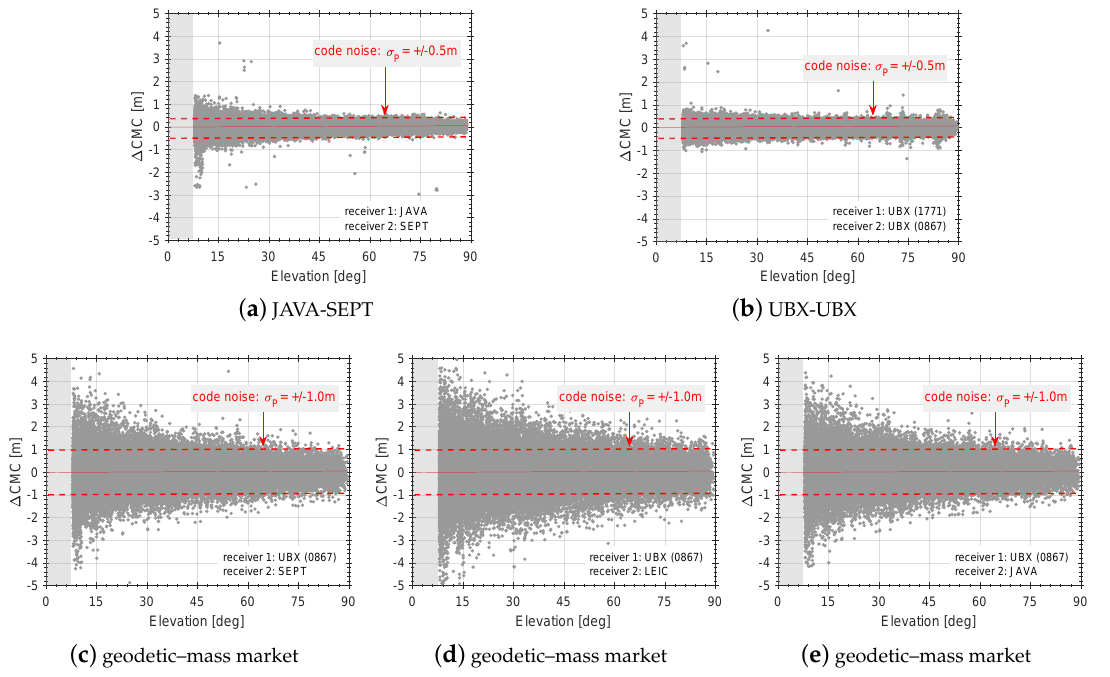
Figure 8. Differential CMC ( ∆ CMC) residuals for several combinations of consumer grade and geodetic receivers versus elevation. An elevation mask of 8 ◦ is applied.